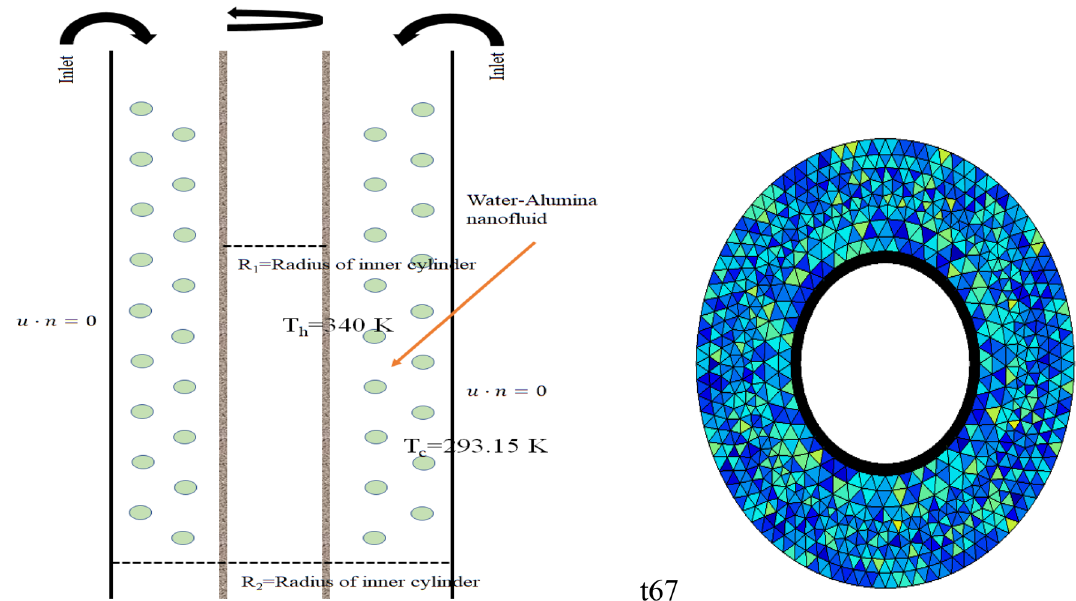
Figure 1. ( a ) Schematic diagram of the channel ( b ) Front view of the channel.